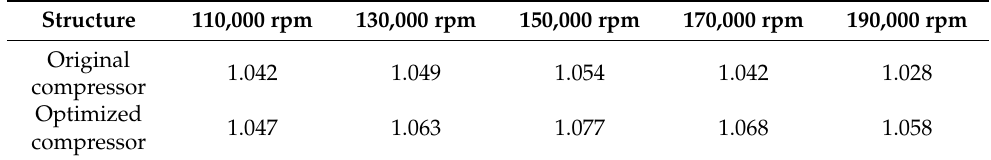
Table 7. Distribution of power consumption coefficients for the compressor unsteady flow.